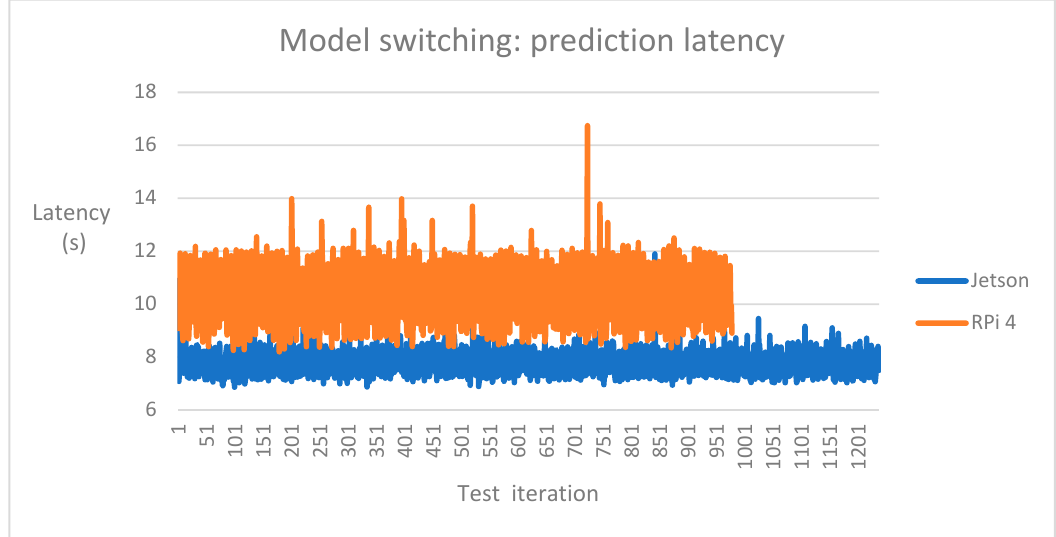
Figure 9. Results of prediction tests with model switching.